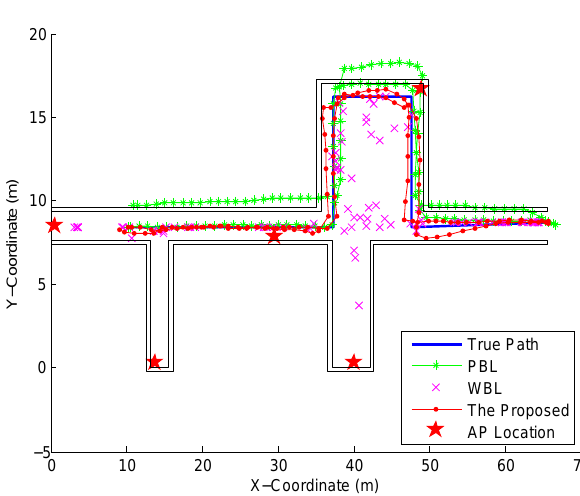
Figure 22. Location tracking by the proposed fusion, PBL, and WBL systems.